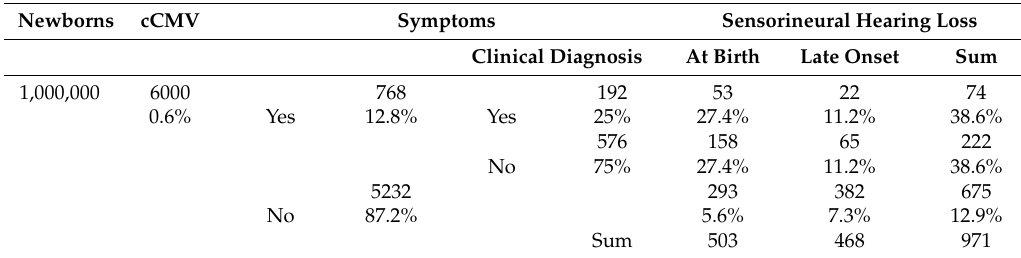
Table 1. Numbers and proportions of cCMV-infected newborns per 1,000,000 births (with/without symptoms, not allowing/allowing clinical diagnosis, that will develop SNHL at birth or at late-onset up to 72 months of age) according to proportions calculated in